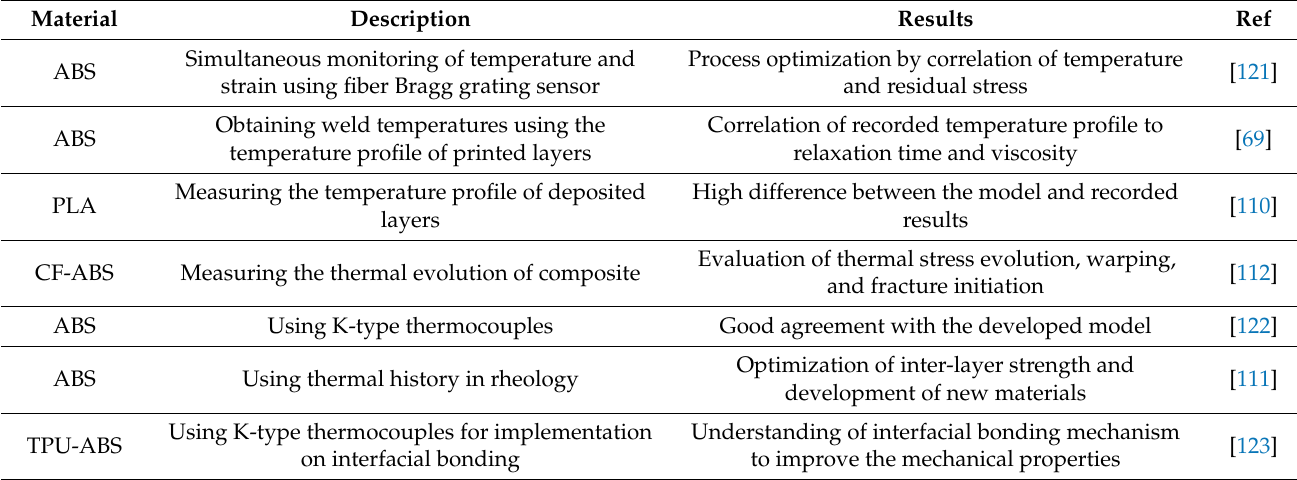
Table 3. Summary of in-process monitoring of temperature profile